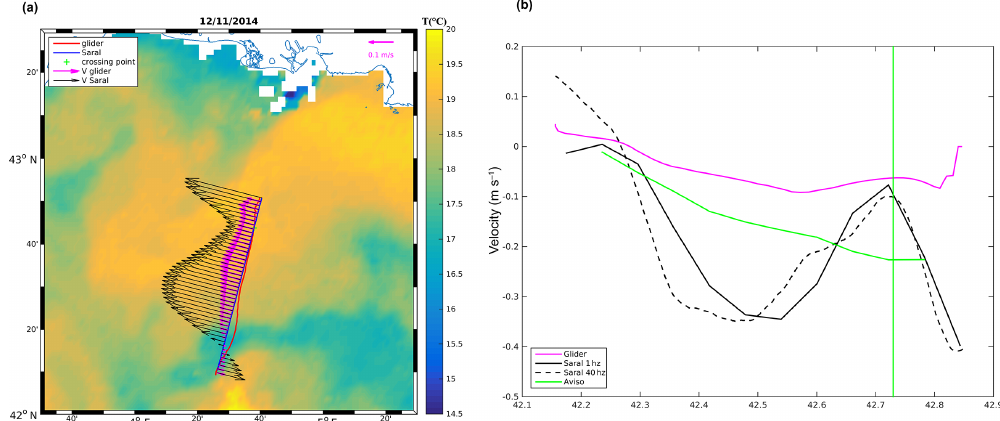
Figure 7. (a) Co-located SARAL track 388 and currents (in black) and glider track and currents (in pink), overlaid with a satellite SST plot on 12 November 2014. (b) Along-track comparison of geostrophic velocities for the glider (including the drift velocities) in pink, and filtered SARAL data in black. Mapped AVISO altimeter data, interpolated back onto the altimeter track, are in green. Green vertical line shows the position when the altimeter data and gliders are co-located. Daily SST fields at 0.02 ◦ resolution from CLS.